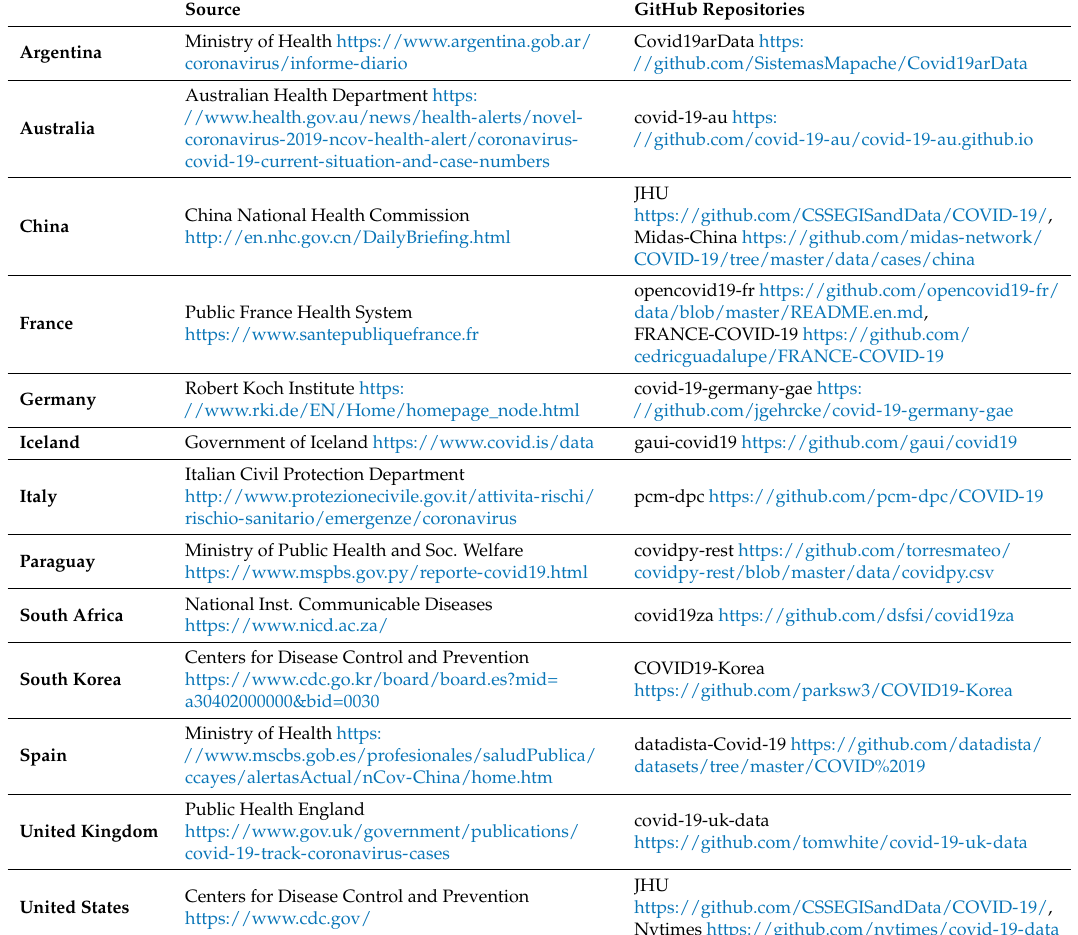
Table 1. Some examples of regional Covid-19 data